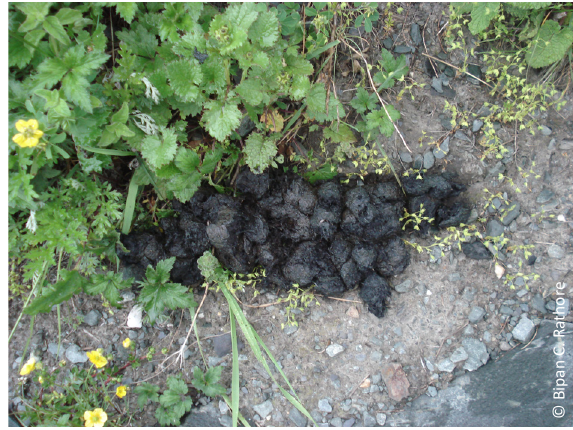
Image 2. Green patch showing herder’s resting place during summer locally known as “Got” in alpine area. Habitat dominated by